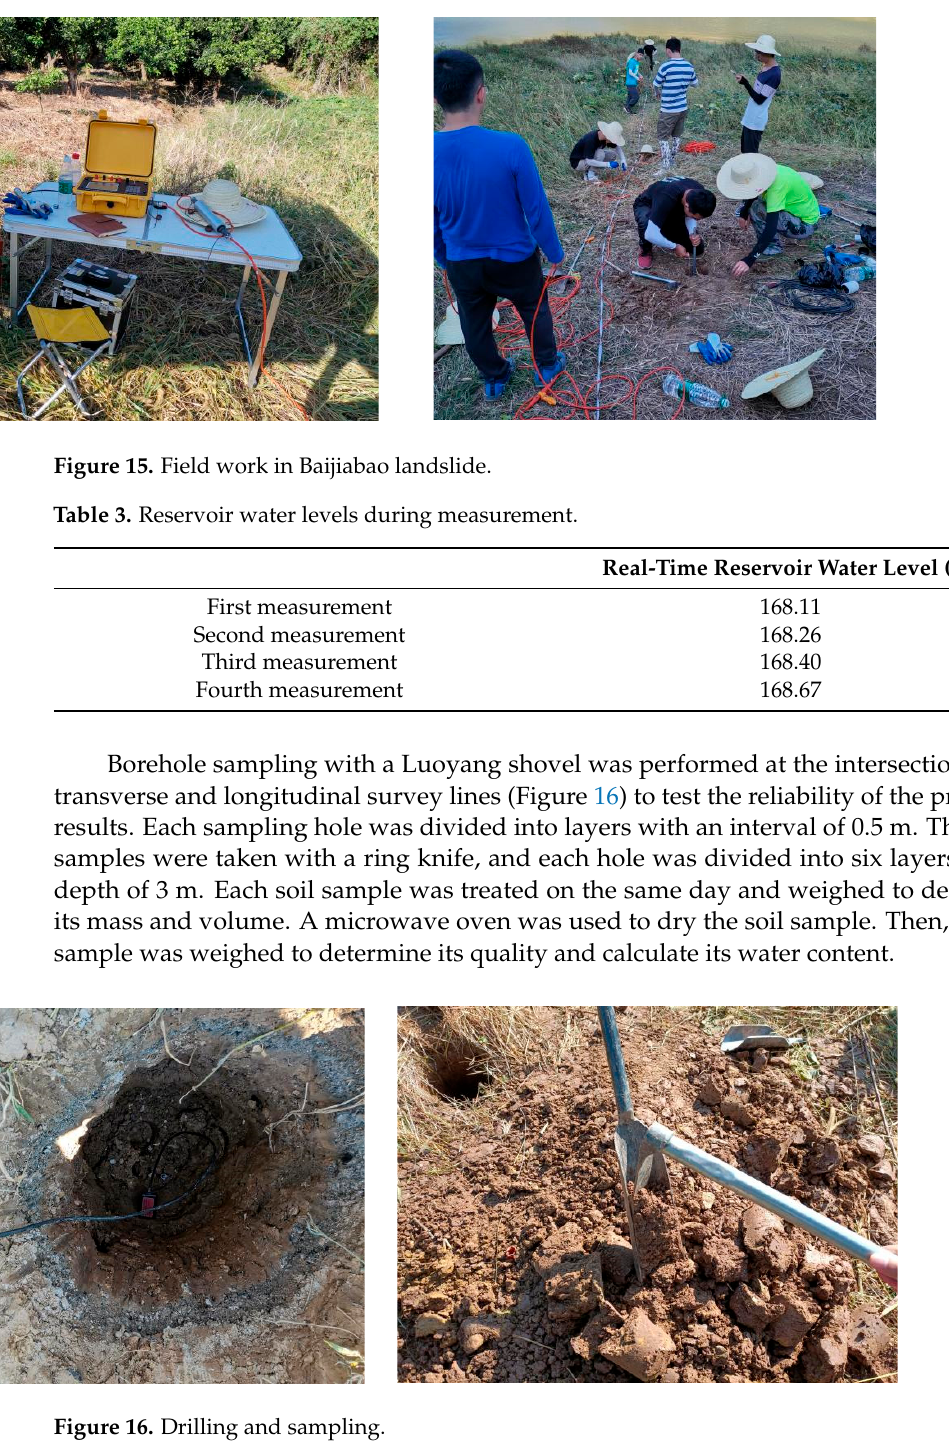
Figure 14. Layout of the high-density electrical survey line of the Baijiabao landslide.